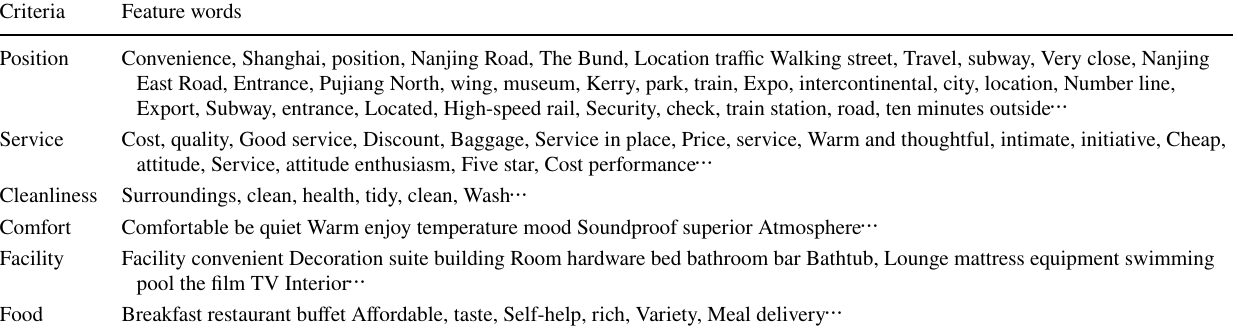
Table 9 Hotel selection criteria and feature words Criteria